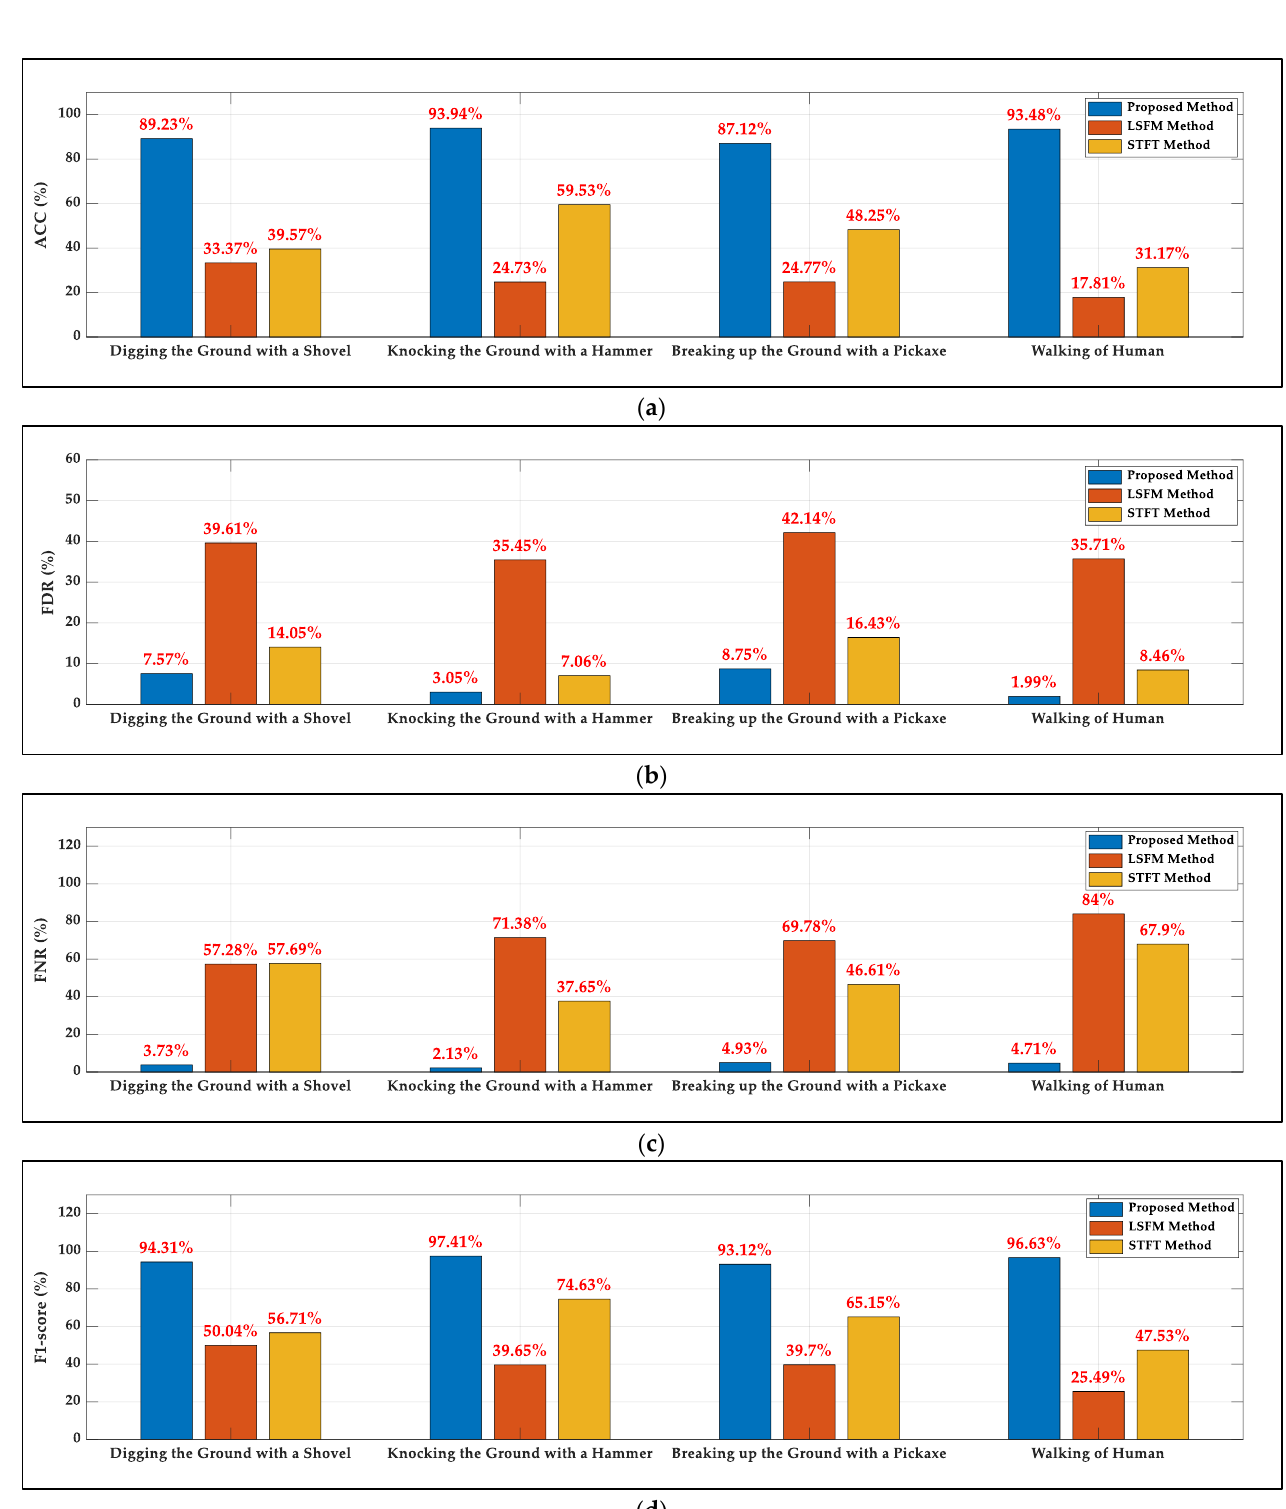
Figure 8. The statistical indicators of the proposed method, the LSFM method and the STFT method for actual database: ( a ) ACC; ( b ) FDR; ( c ) FNR; ( d ) F1-score. Figure 9 gives an example of the manual determination of the onset and the endpoint of the actual signal with the wavelet synchrosqueezed transform (WSST) method, which are chosen as the actual onset and the actual endpoint of actual signal [34], and the error calculations of the onset and endpoint are the same as the simulated data stream. Due to the limitation of the number of correct detections by the LSFM method, 100 samples are